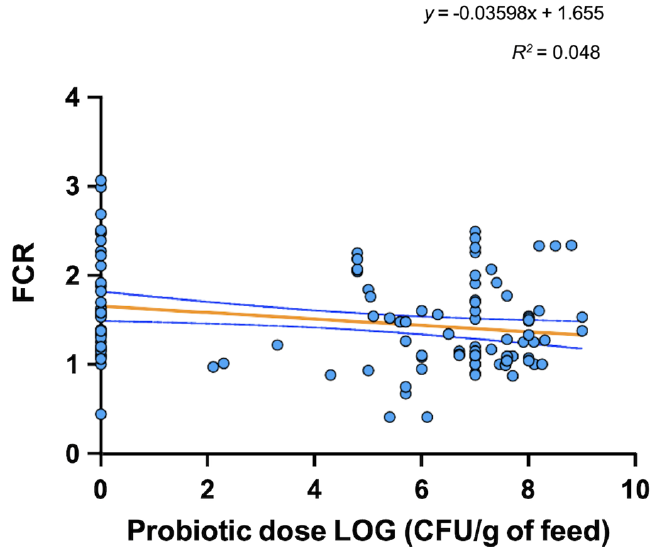
Figure 4. Data analysis revealed significant correlation between probiotic dose in feed and FCR. The circles represent the mean of experimental groups (n = 3; either control group or probiotics treatment group) tested in the studies considered for the regression